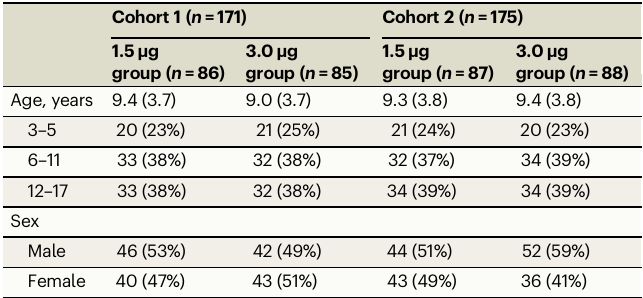
Table 1 | Baseline demographic characteristics of participants who received the third dose Cohort 1 ( n